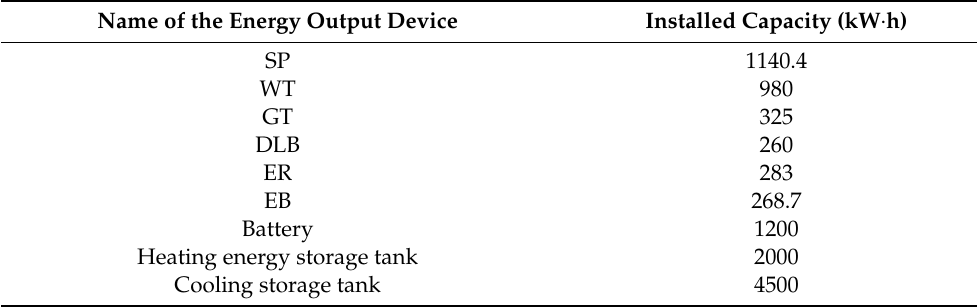
Table 1. System capacity configuration parameters.